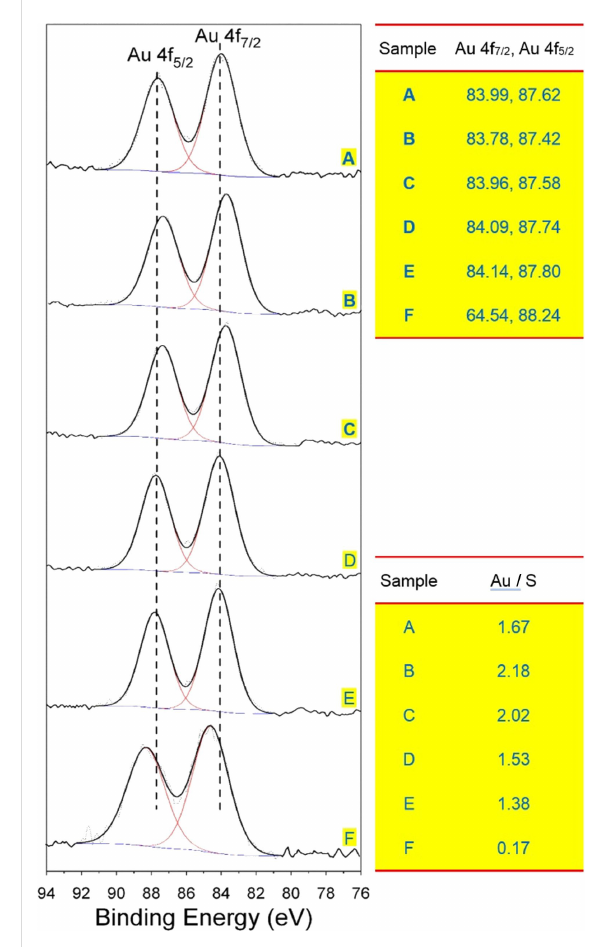
Figure 7: XPS spectra in the Au 4f region of the (A) crude penicil- lamine-protected AuNC product and the sequential size-selected frac- tions (B) F 36% , (C) F 54% , (D) F 72% , (E) F 90% , and (F) F 0% . The right panels display the Au 4f 7/2 and Au 4f 5/2 binding energies and Au/S ratio of the samples determined by